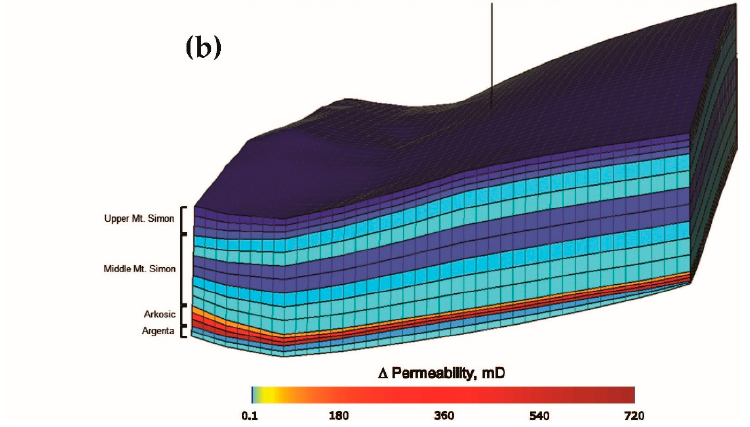
Figure 1. ( a ) Isopach map of the Mt. Simon throughout the Illinois Basin region in central U.S. showing the study area in blue rectangle, and ( b ) block diagram of the 3D permeability model of the study area.